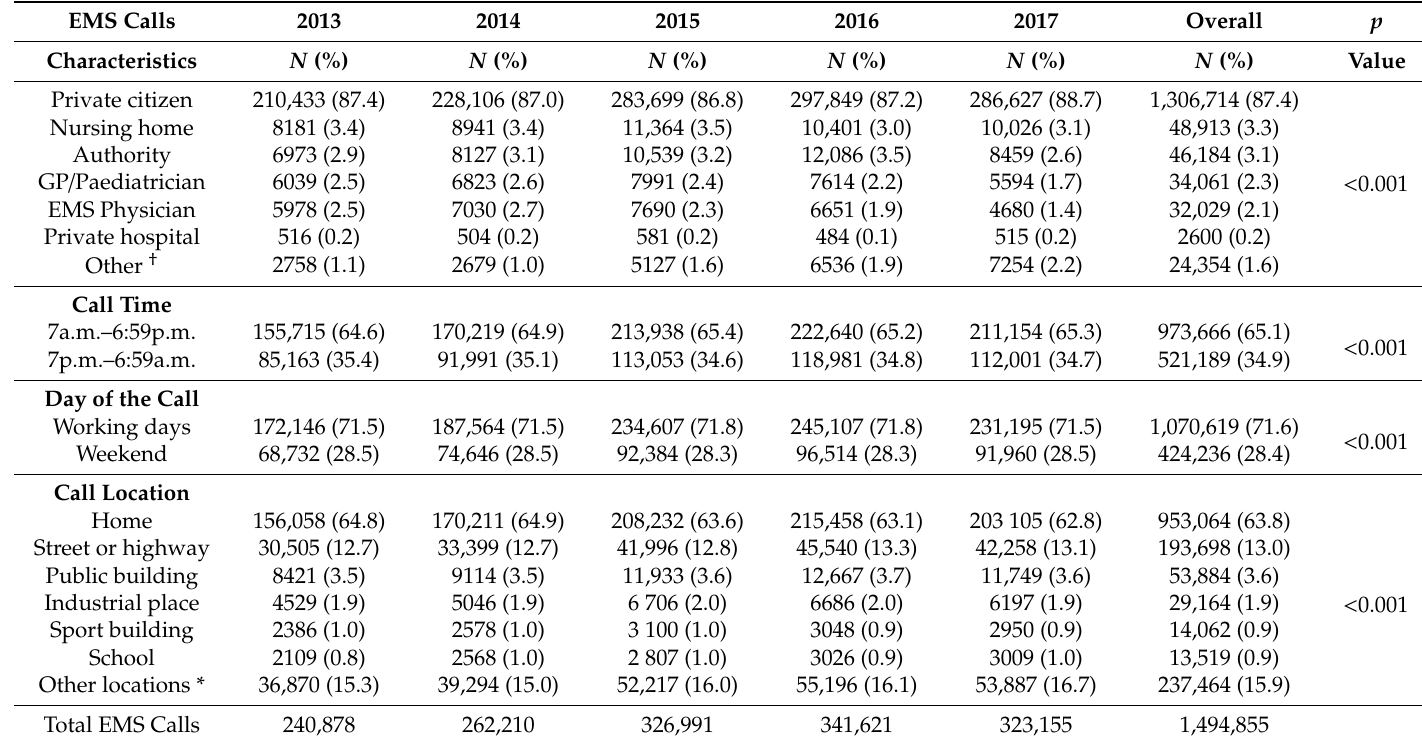
Table 1. Characteristics of Emergency Medical Services (EMS) calls for which at least one rescue vehicle was dispatched, by year